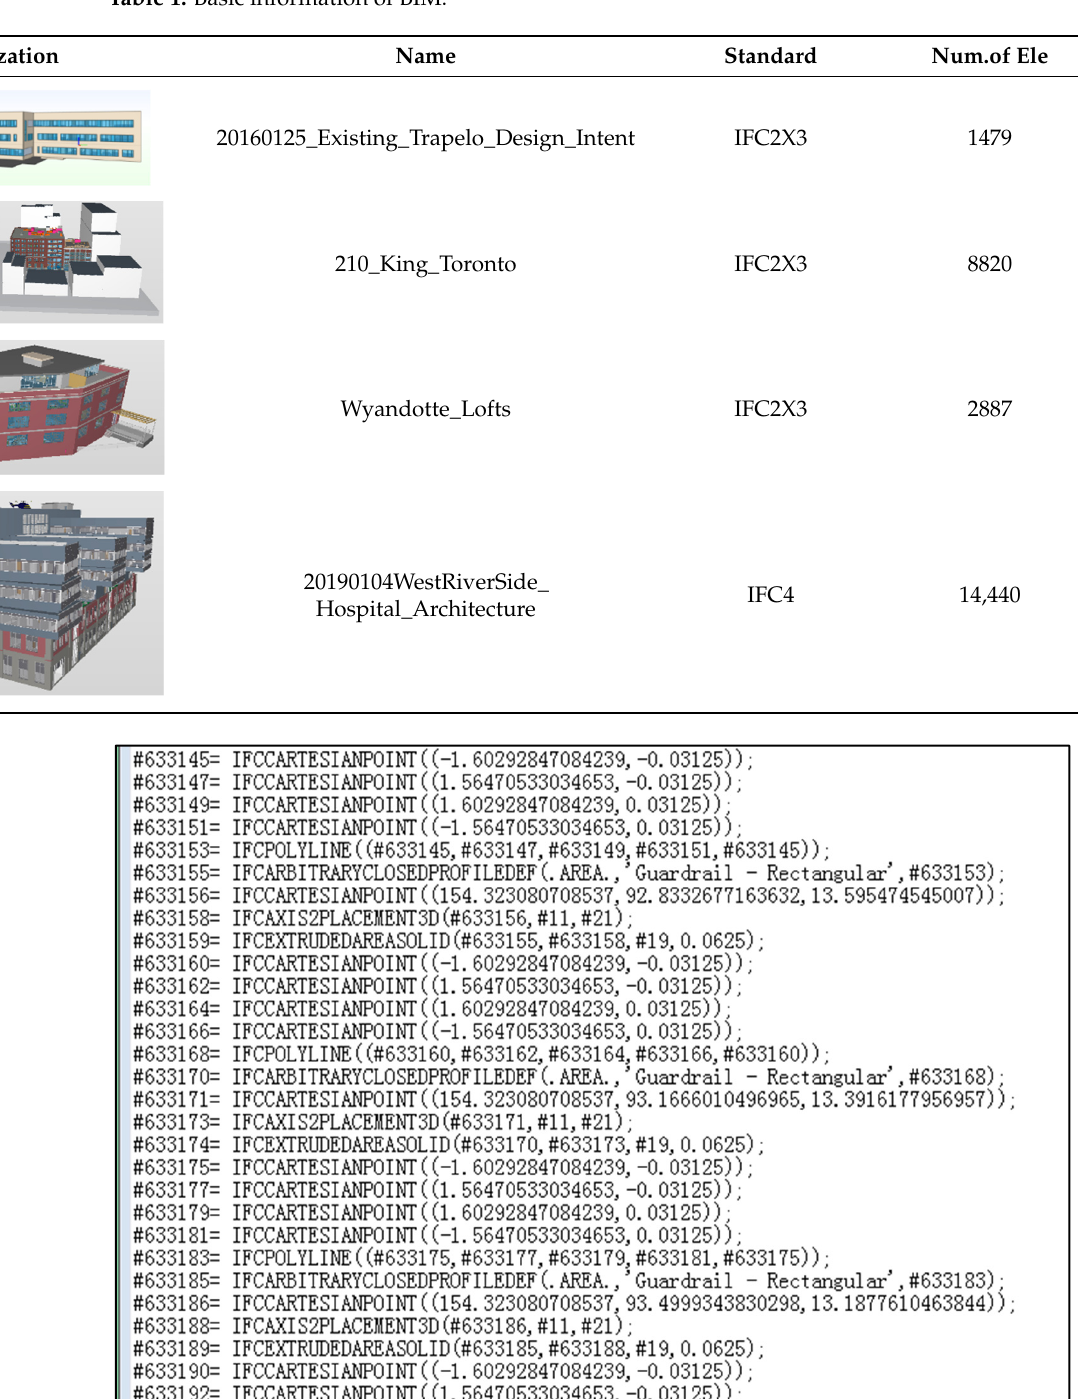
Figure 1. ETDI model TXT display.